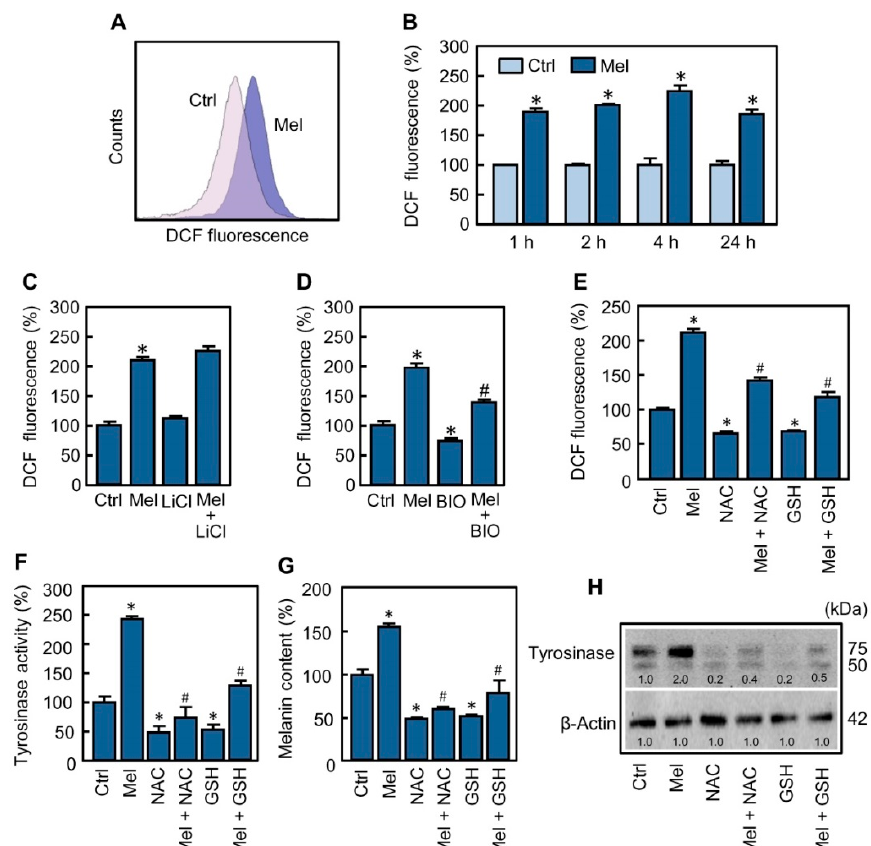
Figure 5. Reactive oxygen species are involved in melanogenesis stimulated by melatonin. ( A ) Cells were cultured with 1 mM melatonin (Mel) for 2 h, stained with H 2 -DCF and the fluorescence emitted by the oxidized fluorochrome was determined by flow cytometry; a representative histogram is shown. ( B ) Cells were treated with 1 mM melatonin for the time interval indicated and analyzed as above; mean fluorescence intensity from the resulting histograms was determined and the values are expressed as percentages of control. ( C , D ) Cells were pre-incubated with 20 mM LiCl, or 0.5 µM BIO, for 2 h and then they were treated with 1 mM melatonin for 4 h; DCF-derived fluorescence was determined as in (B). ( E ) The cells were pre-incubated with 5 mM NAC or GSH for 2 h and then treated with 1 mM melatonin for 4 h; relative ROS levels were determined by flow cytometry. ( F – H ) The cells were pre-treated with 5 mM NAC or GSH for 2 h and then treated with 1 mM melatonin for 72 h. Tyrosinase activity (F) and melanin content (G) were measured from lysates in a microplate reader. (H) Expression of tyrosinase was analyzed by immunoblotting and β -actin was included as a loading control. * p < 0.05 vs. the respective control; # p < 0.05 vs. melatonin treatment alone.